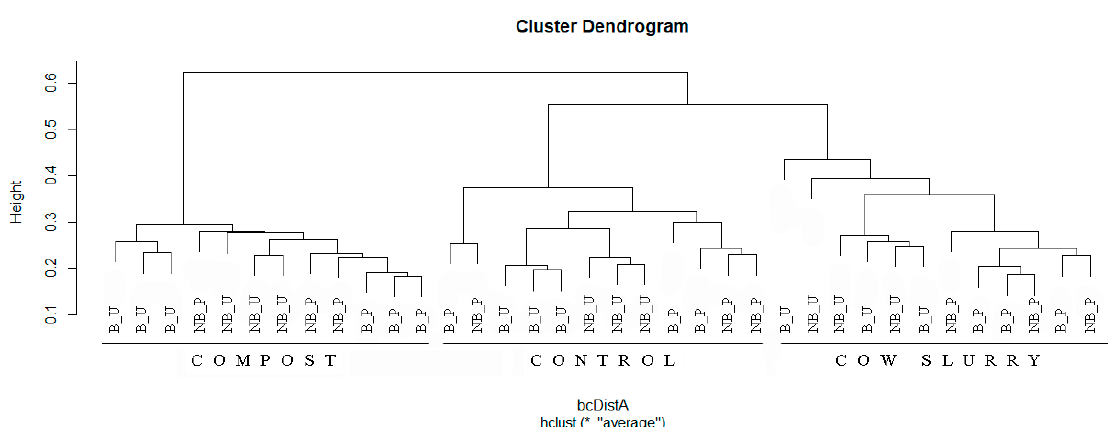
Figure 5. Hierarchical clustering based on Bray Curtis dissimilarities of OTUs from 16S rRNA metabarcoding. B: bioaugmented; NB: non-bioaugmented; U: unplanted; P: planted soils. Compost: amended with composted horse manure; Cow slurry: amended with dried cow slurry.